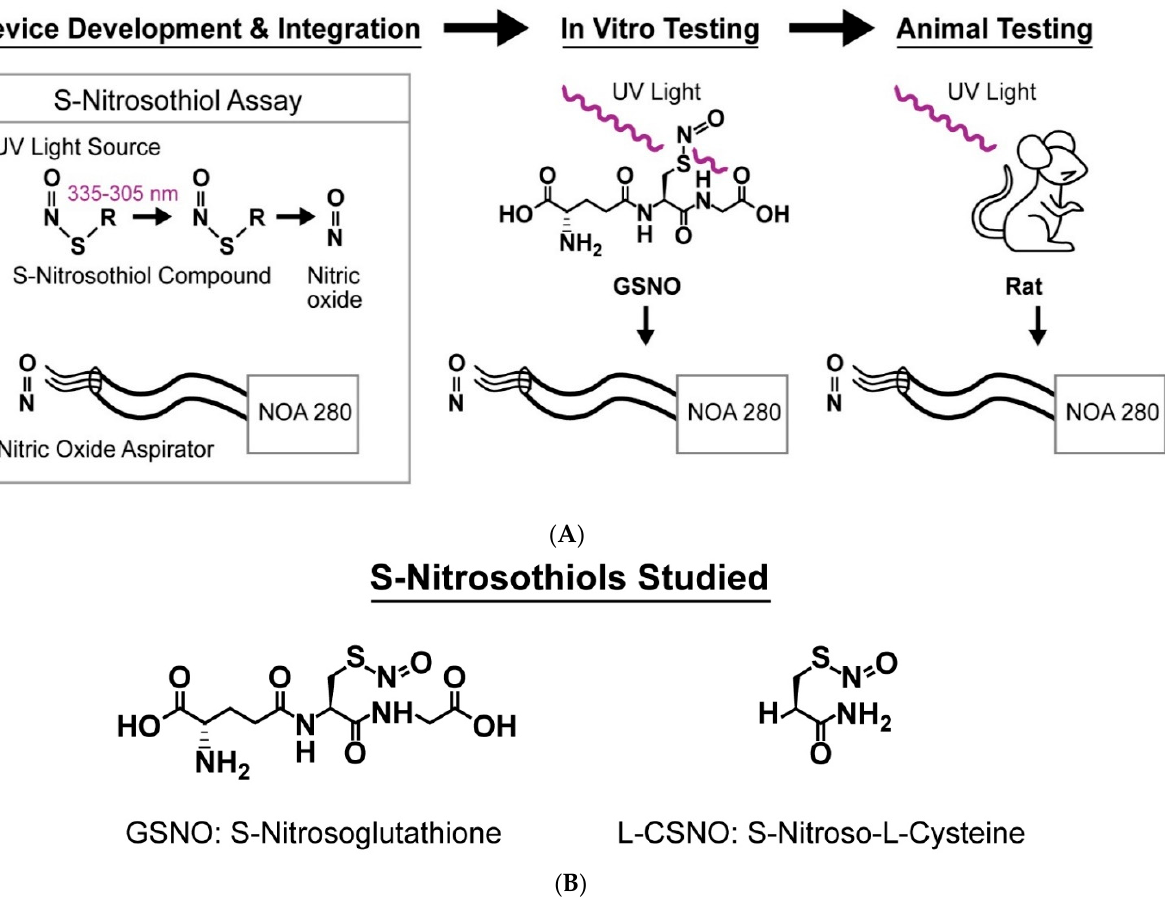
Figure 1. Principles of the UV probe development. (A). The assay uses focused UV light to cleave the S-N bond in the S -nitrosothiol molecules (photolysis) and release nitric oxide (NO). The NO, released from S -nitrosothiols [17], can diffuse through skin and other tissue to be recorded by the chemiluminescence device (here, the NOA280). ( B ). Structure of the S -Nitrosothiols studied.